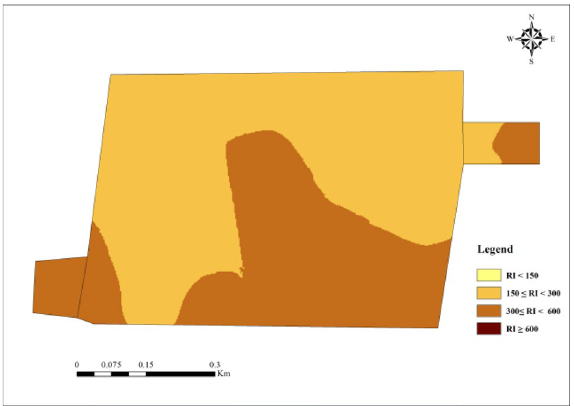
Figure 11. Evaluation results of potential ecological risk index method.